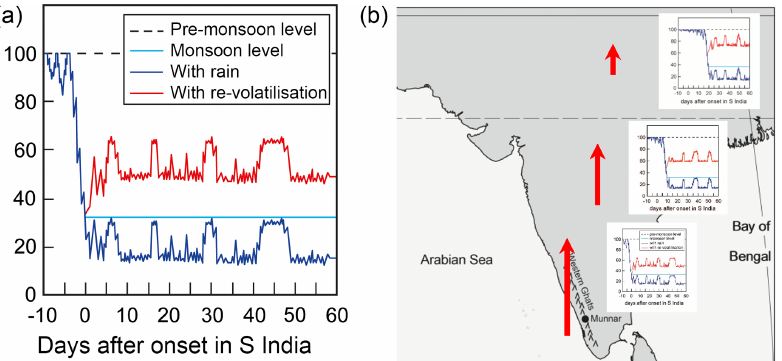
Figure 5. Illustration of temporal (a) and spatial (b) variation in semi-volatile and persistent substance advection over southern, central and northern India in response to the monsoon onset and its northward propagation. Field site is